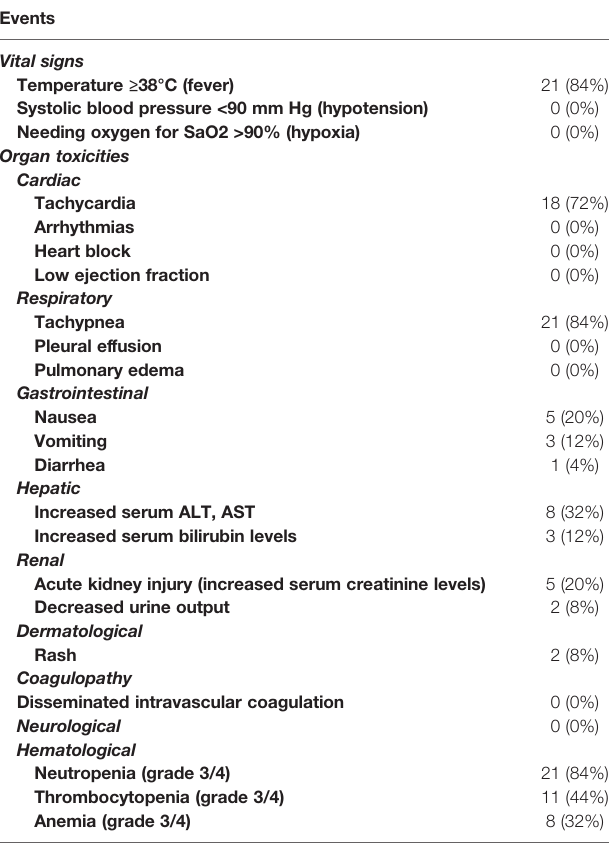
TABLE 3 | Notable adverse events of anti-CD19-CAR-T therapy in patients of the combined group.